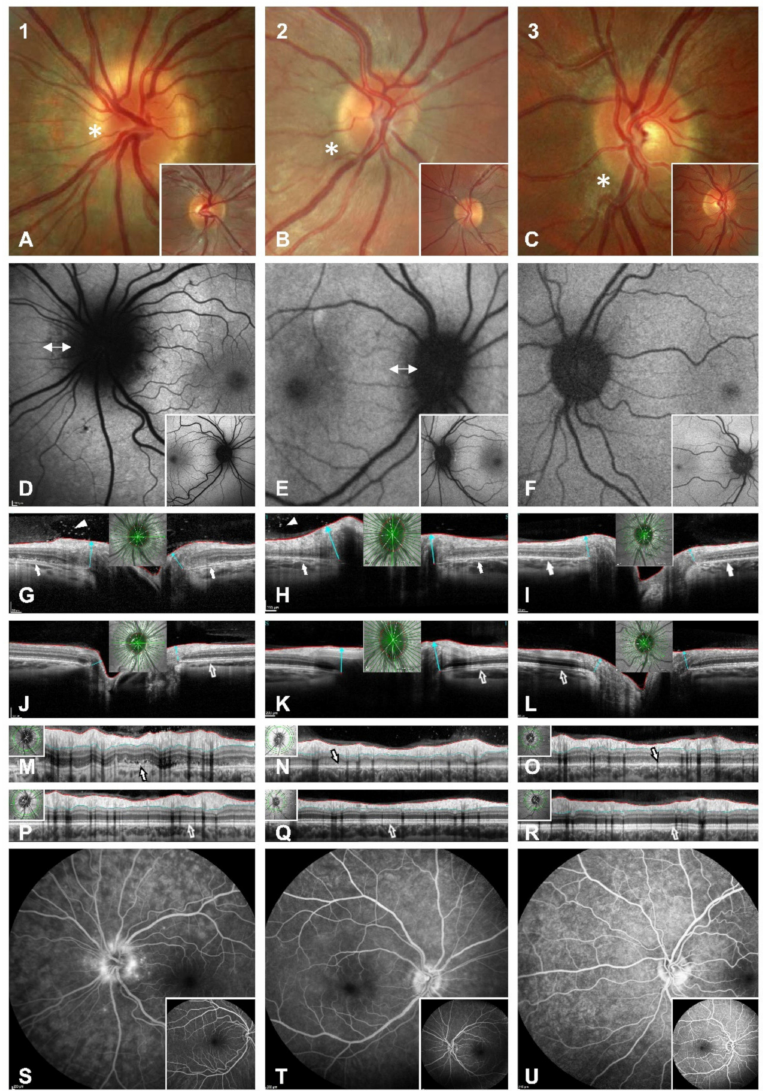
Figure 1. Multimodal imaging of three patients with AIBSES during the first week following the onset of symptoms. Vertical columns show, from left to right, cases 1–3, using SD-OCT (Heidelberg Engineering, Heidelberg, Germany). ( A – C ): Photographs of the optic disc of the affected eye, showing blurred optic disc margins and mild peripapillary colour changes (*), which were most obvious in case 1. Inlets show the contralateral eye. ( D – F ): Fundus autofluorescence imaging discloses circular irregular hypoautofluorescence of the peripapillary retina in cases 1 and 2, marked with arrows. Inlets show the contralateral eye. ( G – L ): Radial OCT cross-sections. Peripapillary irregularity and hyporeflectivity of the retinal pigment epithelium/Bruch’s membrane complex, the interdigitation zone, the outer segments of photoreceptors and the ellipsoid zone are present in all affected eyes (arrows in ( G – I )). The disturbance of retinal layer anatomy is particularly apparent in comparison to the unaffected eyes (empty arrow in ( J – L )). Furthermore, hyperreflectivity in the preretinal vitreous is seen in ( G , H ) (arrowheads). ( M – R ): Retinal nerve fibre layer (RNFL) analysis. Little RNFL elevation is noticeable in the affected eyes of case 1 and 2 ( M , N ), but not in case 3 ( O ), compared to the unaffected eyes ( P – R ). The impairment of the peripapillary outer retinal layers is also